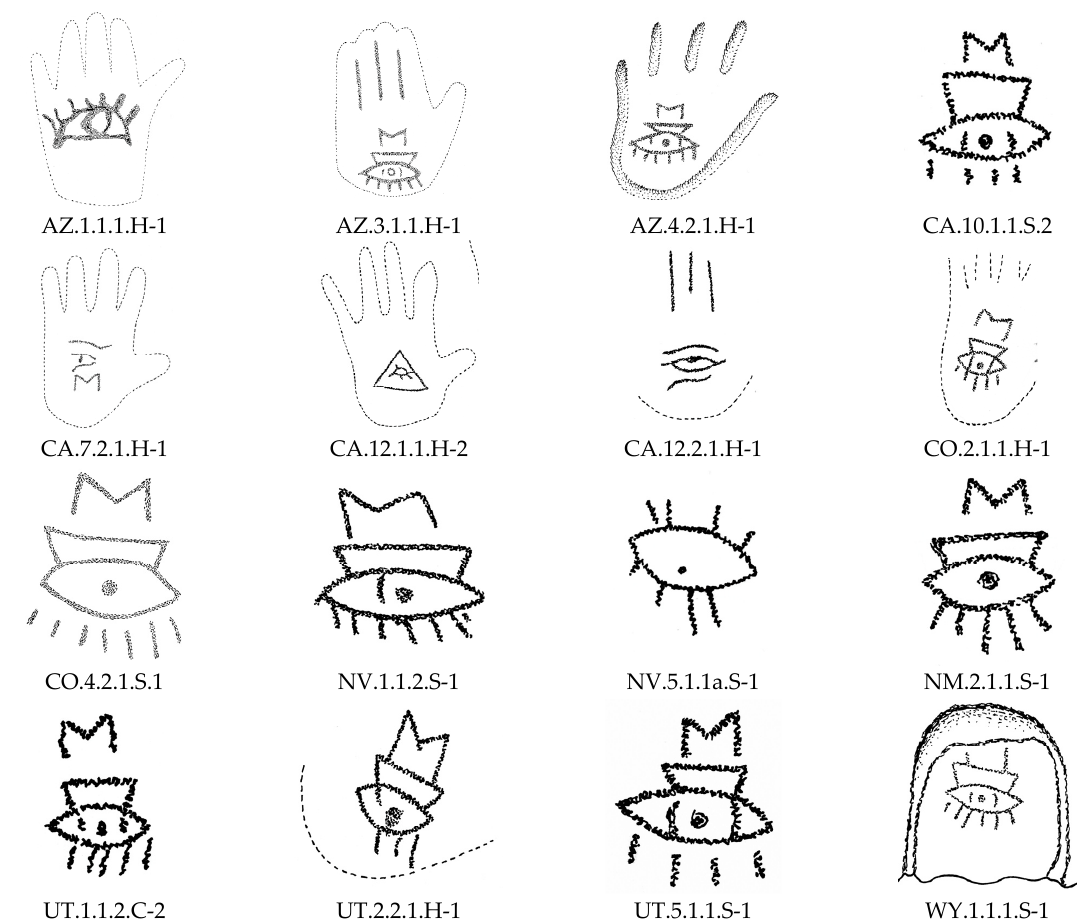
Figure 39. Weeping -eye and Radiant-eye designs (drawings by David Lee).